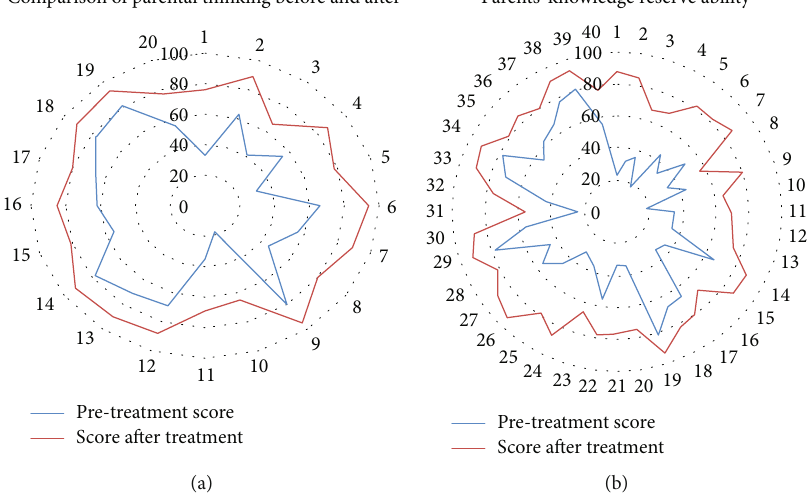
Figure 8: Comparison of parents ’ ability before and after the implementation of the